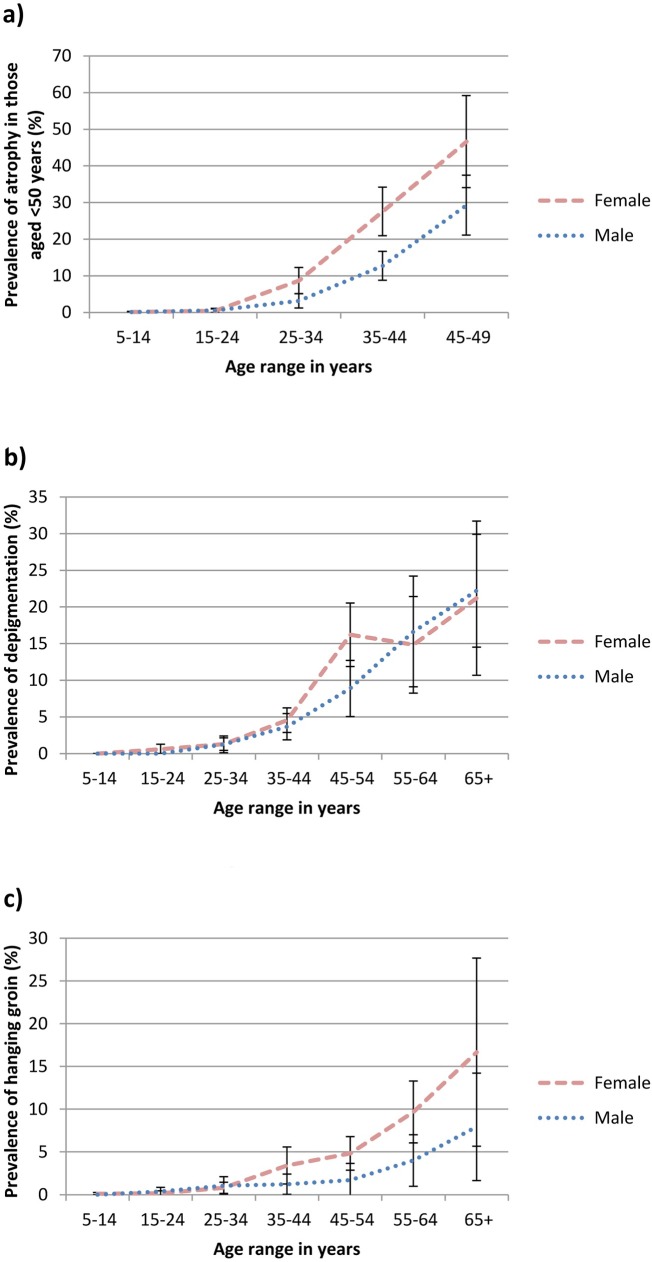
Age and gender-specific prevalence of a) atrophy in individuals aged < 50 years, b) depigmentation and c) hanging groin in endemic savanna communities, Kaduna State, Northern Nigeria. Error bars represent mean and 95% CI.